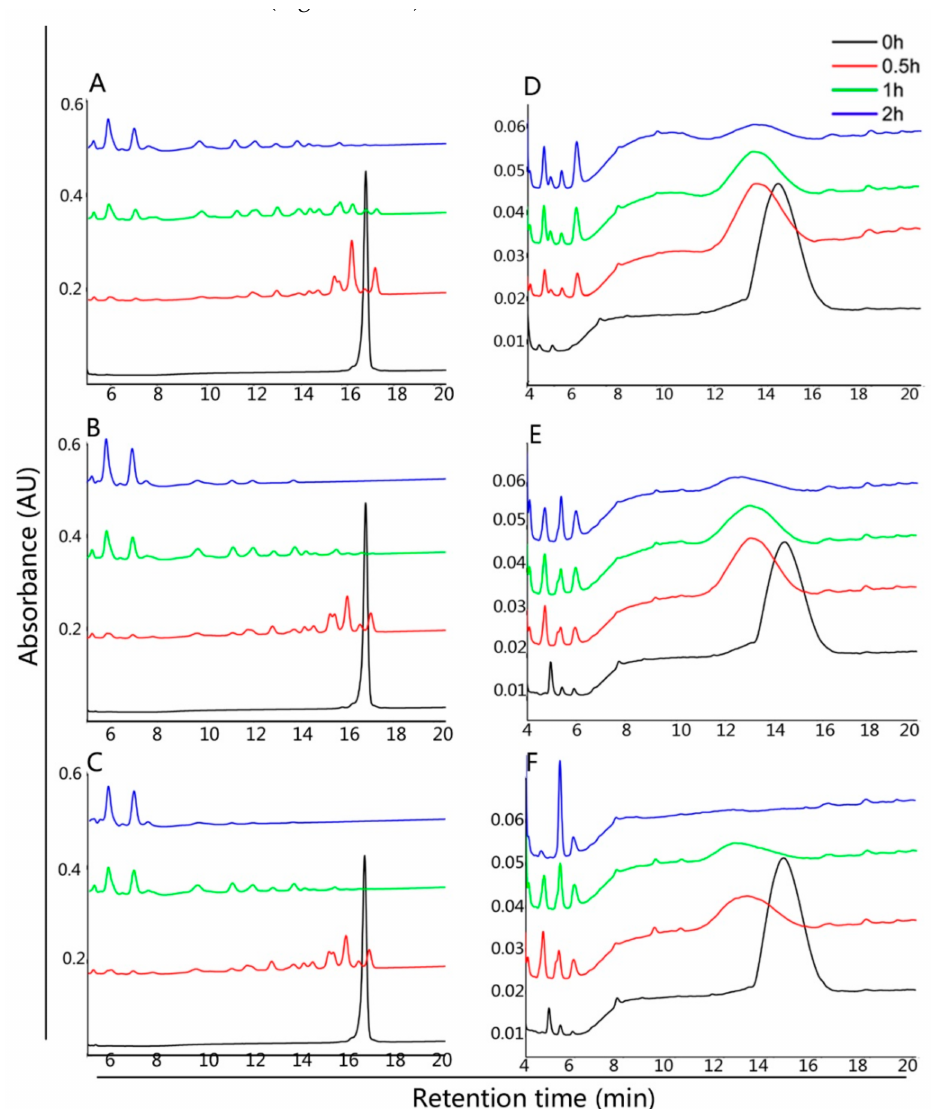
Figure 2. HPLC analysis of the degradation profiles of immunotoxic peptides. The cell densities used for the incubations were OD 620 1.2. The initial concentration of 33-mer gliadin peptide and 13-mer gliadin peptide was 0.5 mg/mL and 0.25 mg/mL. The 33-mer gliadin peptide was incubated with B. cereus CH ( A ), B. cereus 21155 ( B) and B. cereus AFA01 ( C ) for 0, 0.5, 1 and 2 h, respectively. The 13-mer gliadin peptide was incubated with B. cereus CH ( D ), B. cereus 21155 ( E ) and B. cereus AFA01 ( F ) for 0, 0.5, 1 and 2 h,